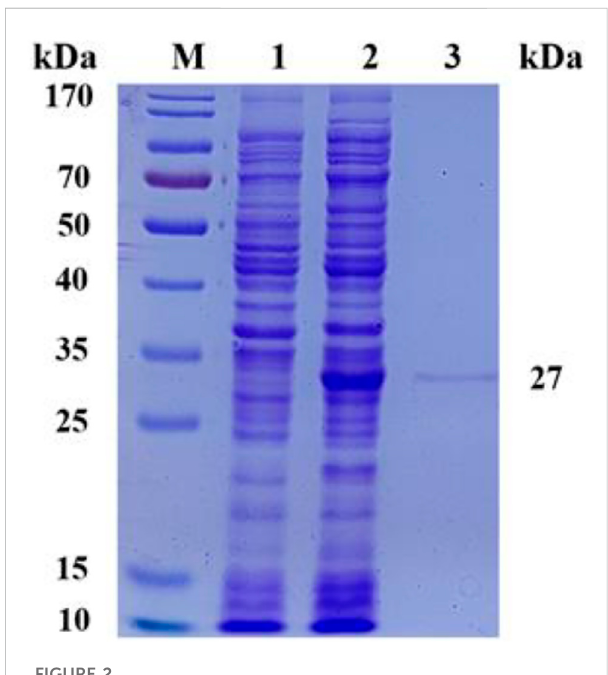
FIGURE 2 SDS-PAGE analysis of recombinant Escherichia coli expression products. SDS-PAGE analysis of recombinant Escherichia coli expression products M, PageRuler Prestained Protein Ladder; 1, expression products of E. coli BL21 (DE3)/pET28a; 2, crude expression product of E. coli BL21 (DE3)/pET28a- Sc NRK1; 3, puri fi